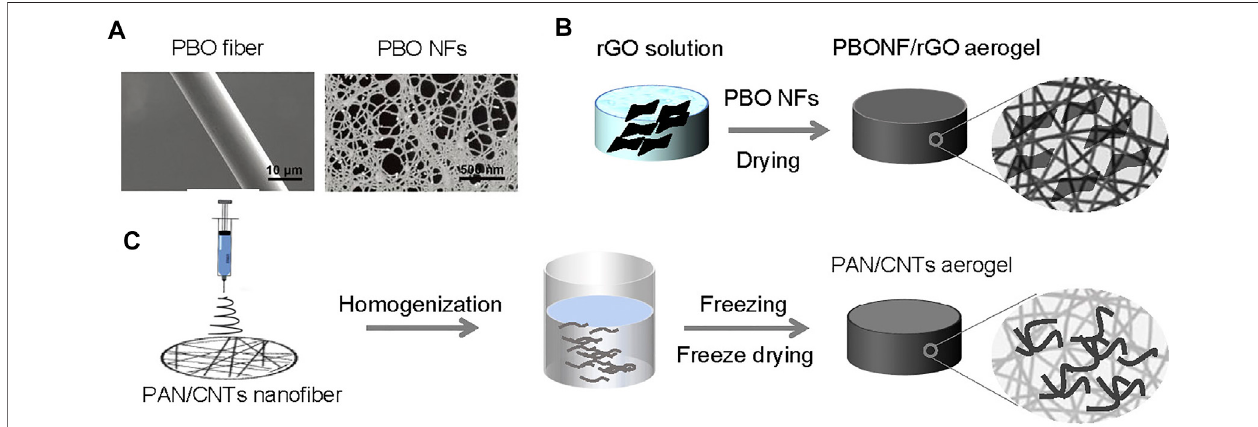
FIGURE 4 | Petrochemical polymer nano fi bers as building blocks for fi brous aerogels. (A) SEM images of the commercial PBO fi ber and the exfoliated PBO nano fi bers. Reprinted with permission from (Chen et al., 2018).Copyright (2018) The Royal Society of Chemistry. (B) Synthesis ofnano fi brous SVG (all-in-onestructure) usingPBOnano fi bersasbuildingblocksandrGOasphotothermalmaterials(ChenM.etal.,2021). (C) SynthesisofCNTs-containingPANnano fi bersandcorresponding SVG aerogels (all-in-one structure) (Liu et al.,